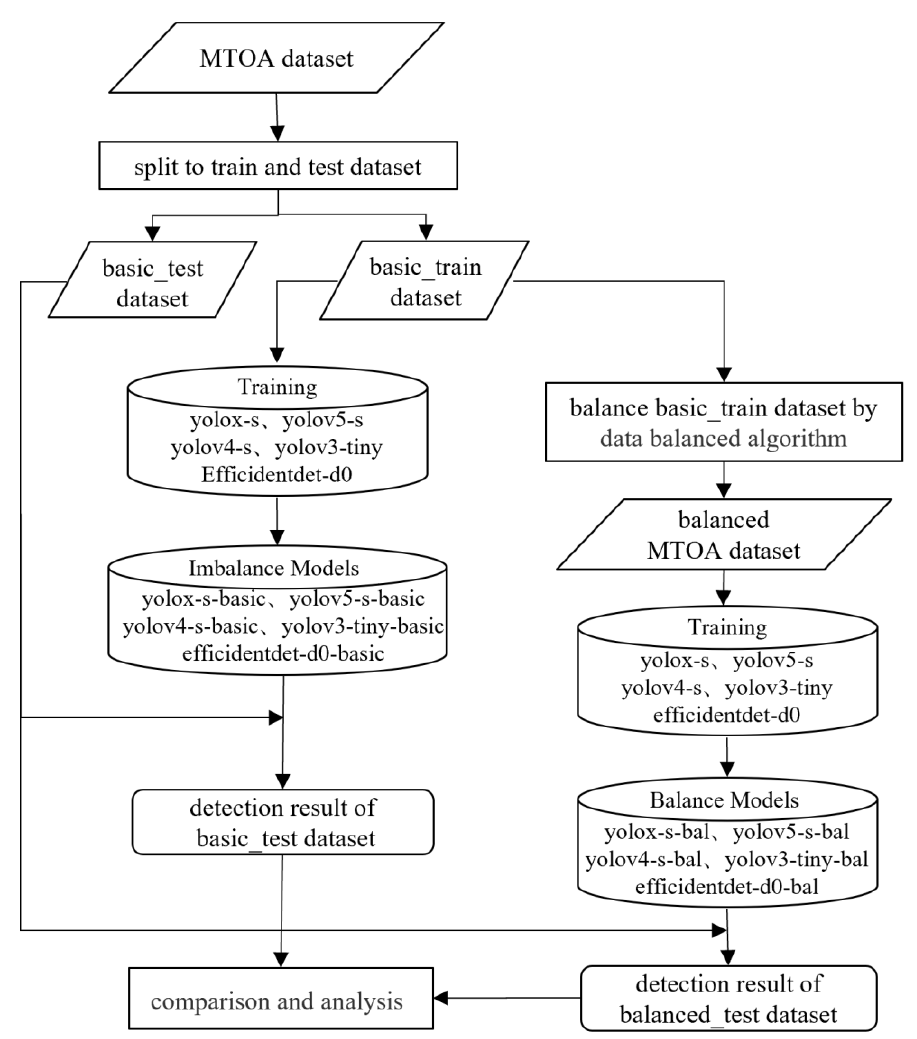
Figure 3. Flow chart for the validation of the proposed method.